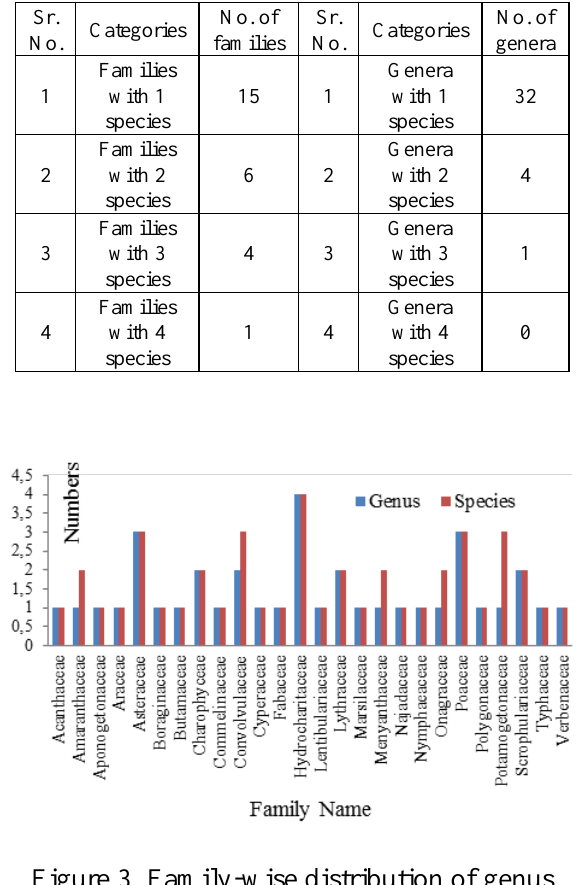
Figure 3. Family-wise distribution of genus and